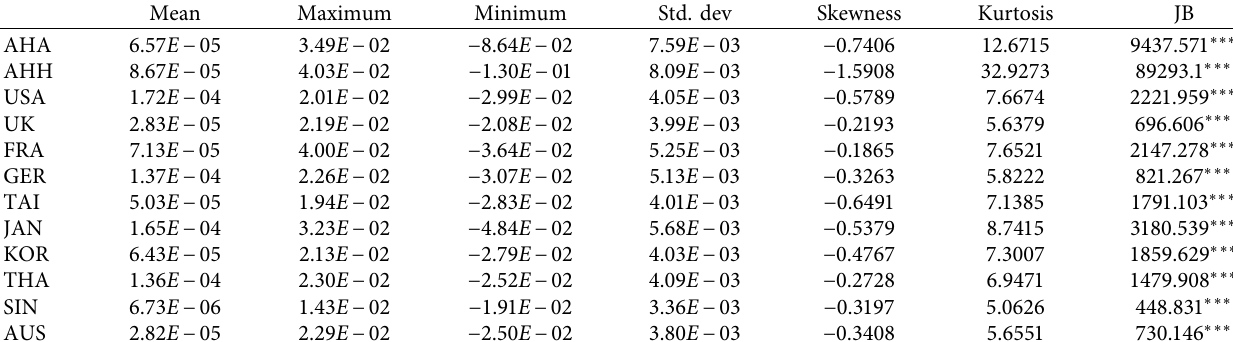
Table 1: Descriptive statistics of the return series for AHA, AHH, and the other ten pairs for the overall period. Mean